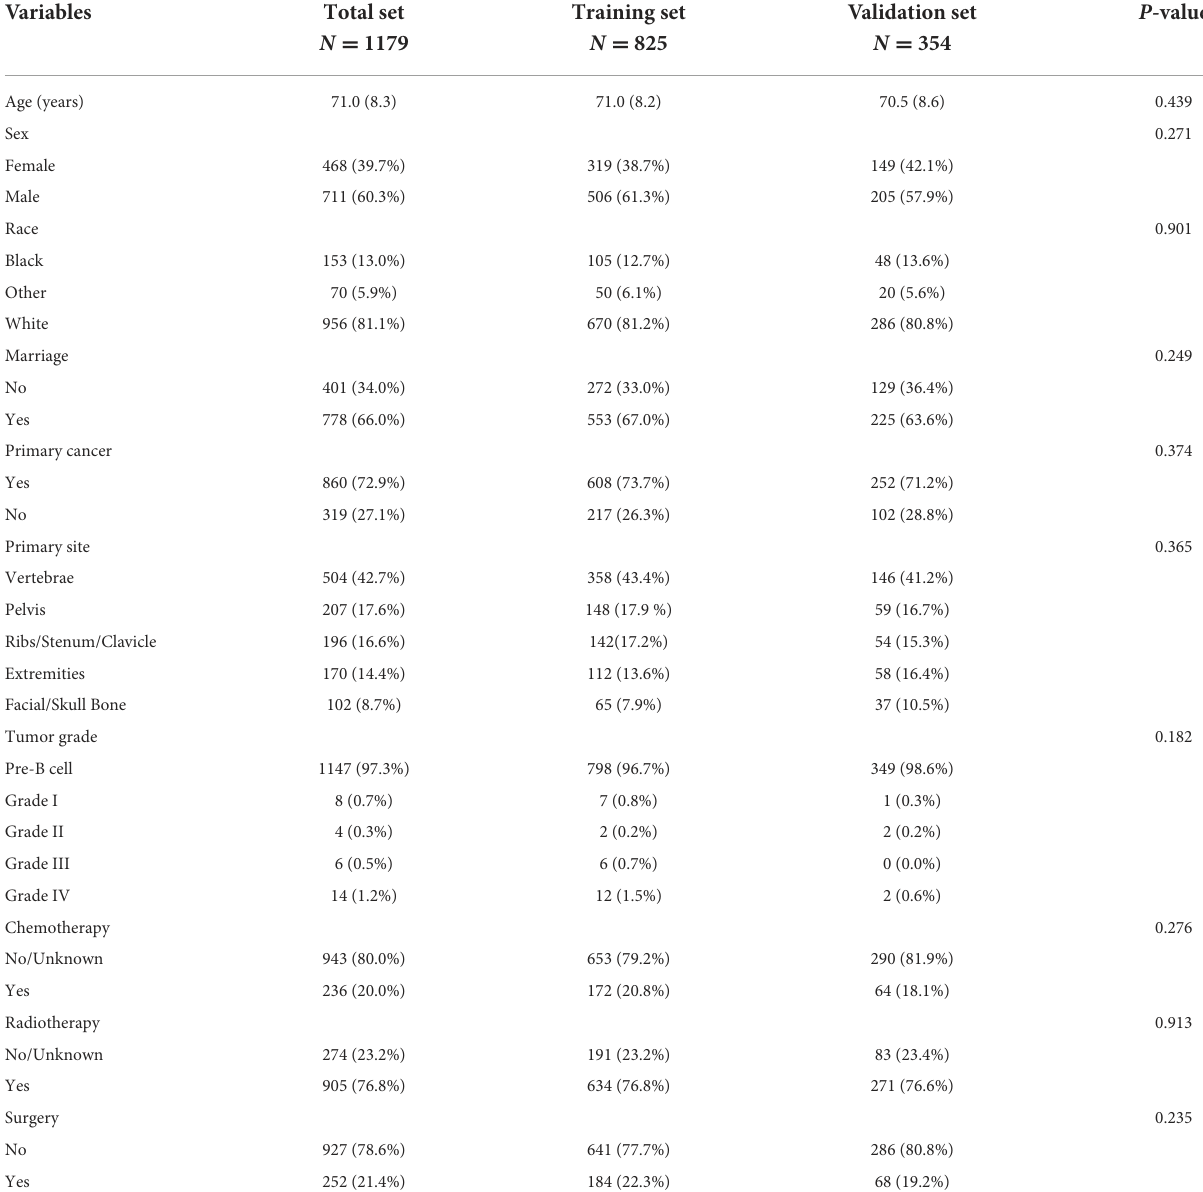
TABLE 1 Baseline demographic and clinical characteristics of SPB